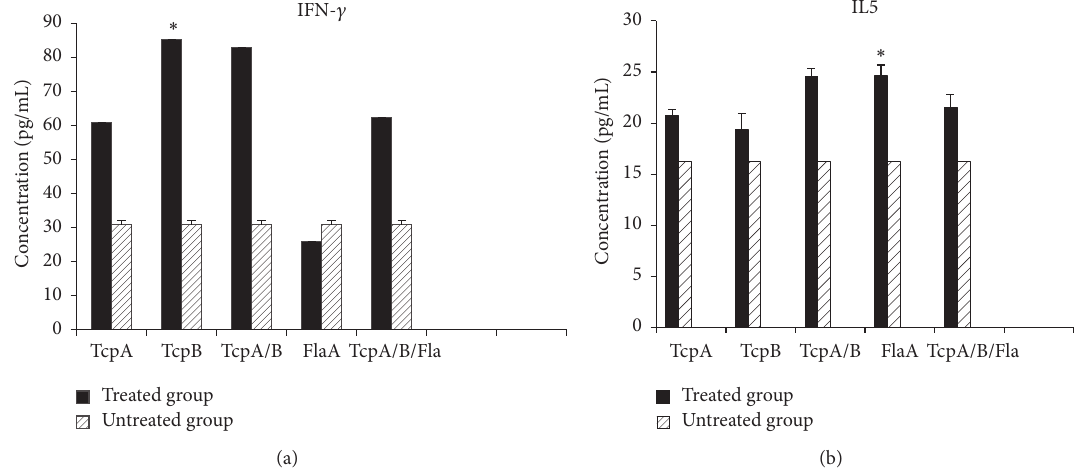
Figure 3: Quantitative ELISA analysis of IFN- 𝛾 (a) and IL5 (b) measured in the supernatant of the MNCs isolated from the spleen of mice immunized with specific recombinant proteins. Significant differences were designated as ∗ 𝑃 < 0.05